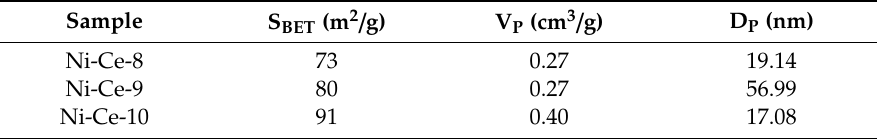
Figure 3. Nitrogen adsorption / desorption isotherms and pore size distribution of Ni-Ce-pH catalysts after calcination at 600 °C: ( a ) Ni-Ce-8; ( b ) Ni-Ce-9 and ( c ) Ni-Ce-10. Table 3. Textural properties of Ni-Ce-pH catalysts.